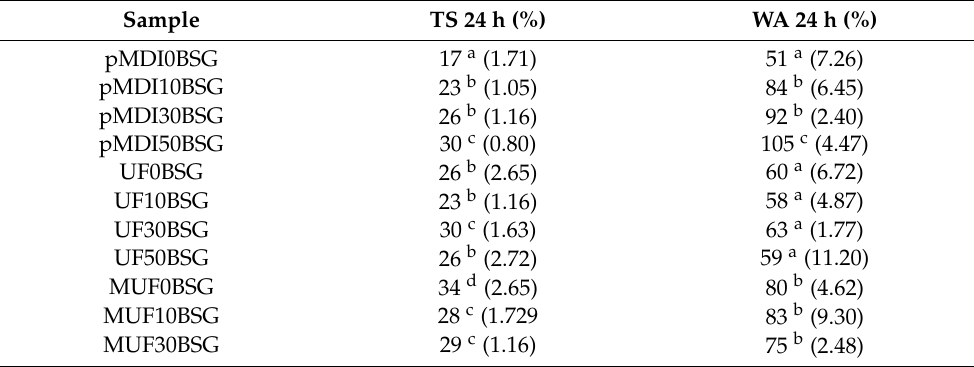
Table 4. Results of the thickness swelling and water uptake of the 15 mm particleboards (a, b, c, d values with the same letter are not significantly different: ANOVA, Post-Hoc Tukey HSD, α = 0.05).